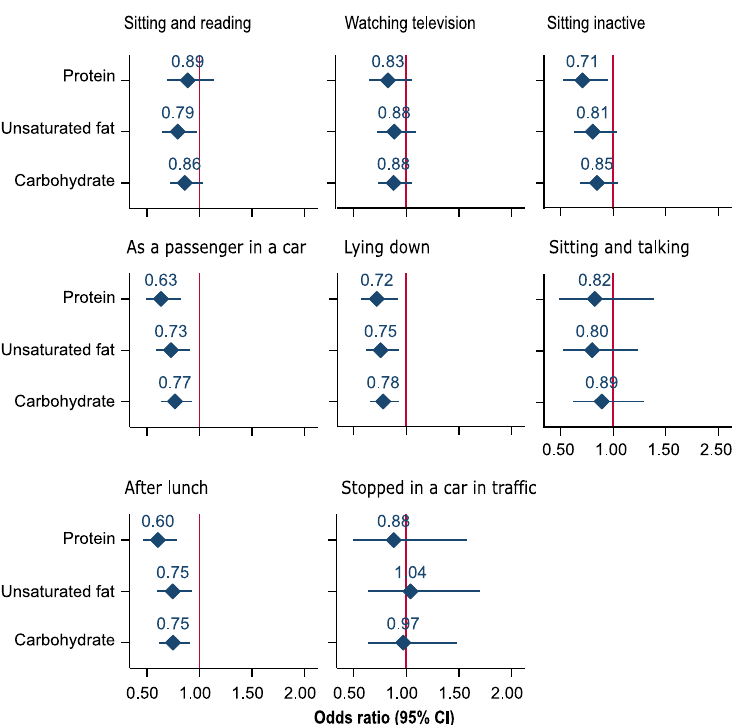
Figure 4. Odds ratio (95% confidence intervals) for excessive daytime sleepiness associated with a 5% decrease of energy per day from saturated fat and a simultaneous 5% increase of energy per day from protein, unsaturated fat, and carbohydrate in the North West Adelaide Health Study. (Nutrient density model. The model was adjusted for total energy intake from fat, carbohydrate, protein, sex, age (continuous), marital status, education, work status, Socio-Economic Indexes for Areas, waist-to-hip ratio (continues), alcohol intake, exercise level, sleep duration, pulse pressure (continuous), sleep apnea, diabetes status, and depression.).